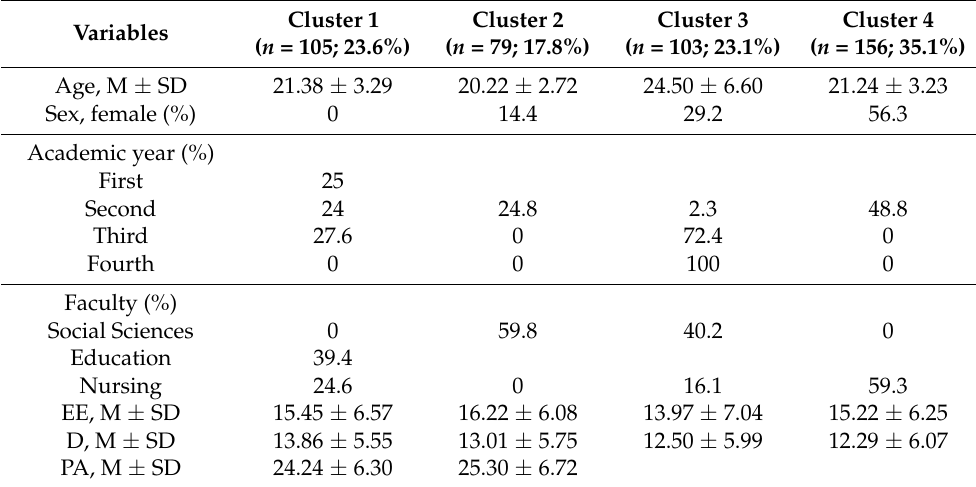
Table 1. Cluster analysis profile with the full sample ( n =